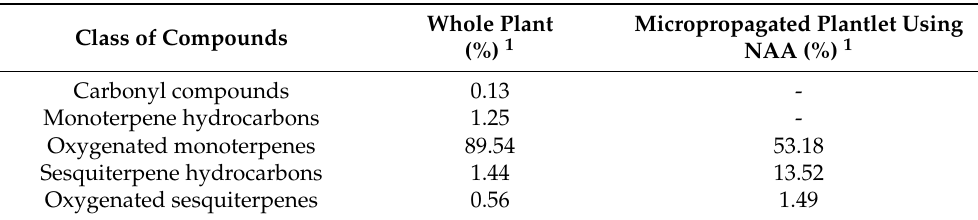
Table 4. The content of different classes of identified volatile organic compounds in whole plant and micropropagated plantlet using